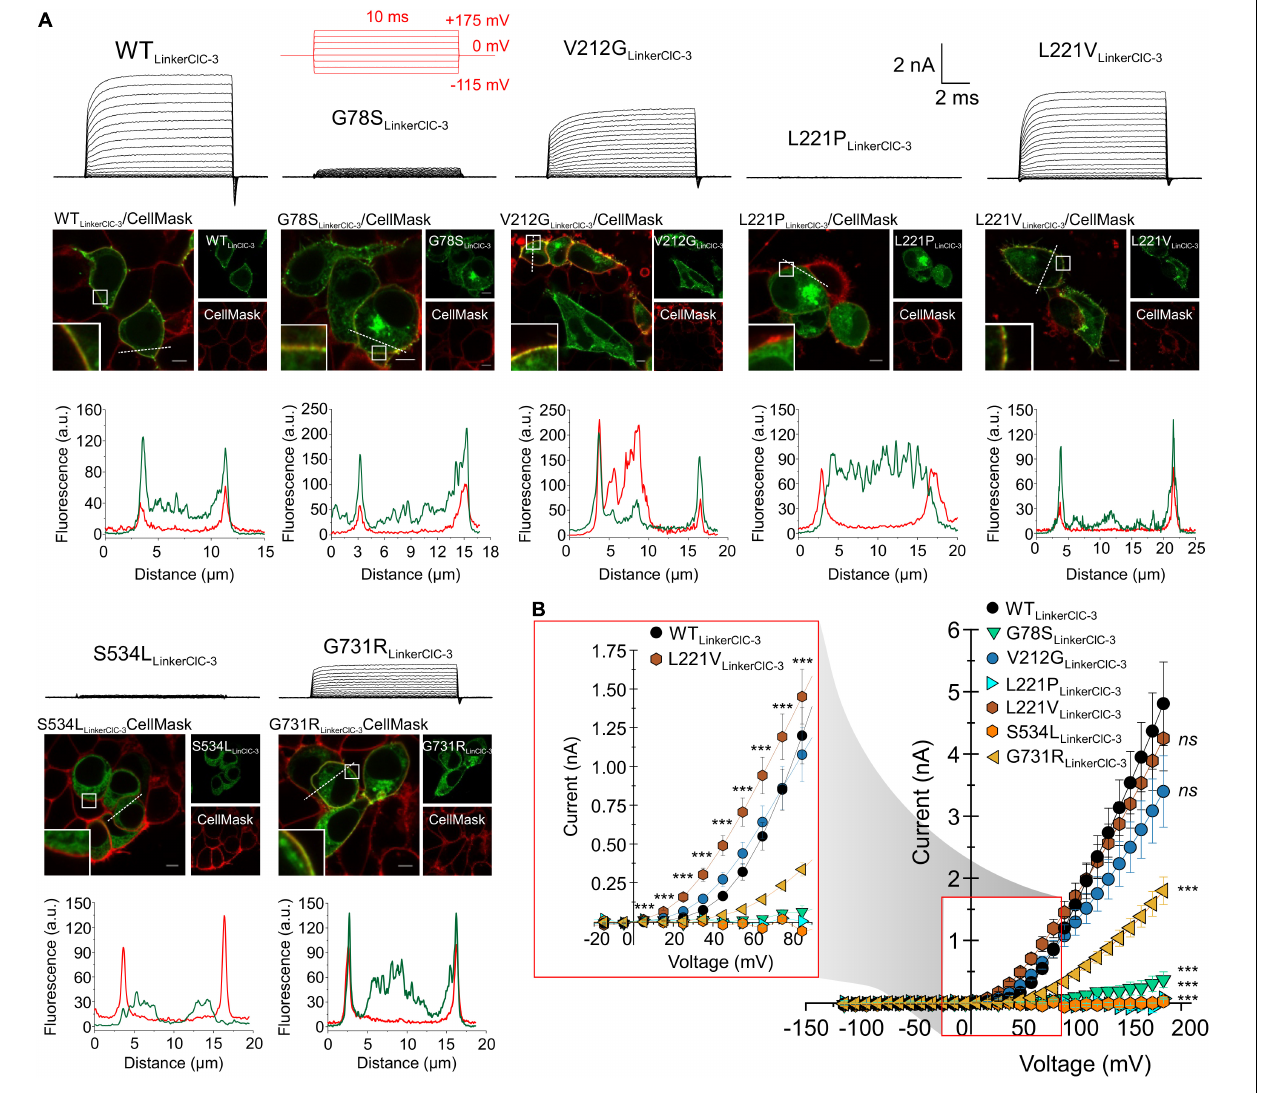
FIGURE 5 | Subcellular expression and transport functions of WT and mutant chimeric ClC-4 LinkerClC − 3 . (A) Test pulse protocol (in red) and representative transport currents (black traces) for chimeric WT, G78S, V212G, L221P, L221V, S534L, or G731R ClC-4 LinkerClC − 3 expressed in HEK293T cells (upper panels). Representative confocal images of HEK293T cells co-expressing WT or mutants chimeric ClC-4 LinkerClC − 3 together with the plasma membrane marker CellMask (middle panels) and line scan analyses illustrating that subcellular distribution pattern at both channels (dashed lines), (lower panels), (a.u. denotes arbitrary units). Inset shows areas outlined in the white boxes. Scale bars 5 µ m. (B) Steady-state current-voltage relationships (mean value ± s.e.m.) for WT and mutant ClC-4 chimeric proteins. The inset gives an expanded view of the current-voltage relationship (WT, n = 14; G78S, n = 10; V212G, n = 12; L221P, n = 4; L221V, n = 12; S534L, n = 8; and G731R, n = 11). Data were obtained from four or five independent